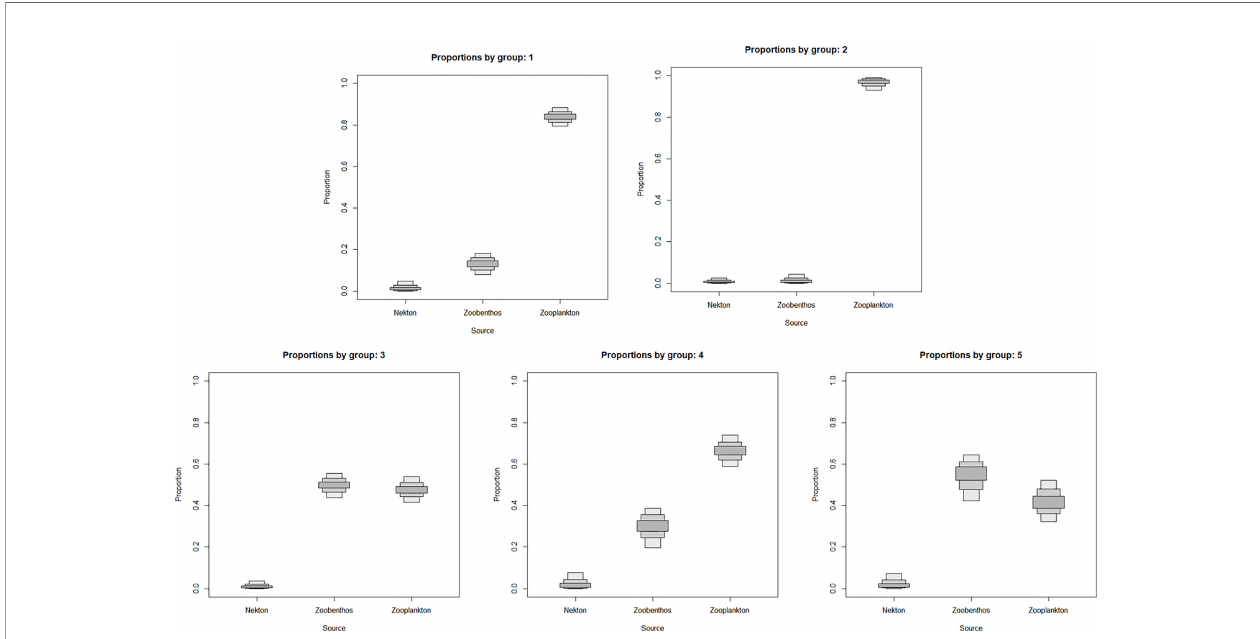
FIGURE 3 | Contributions of different food sources to fi ve sciaenid fi shes collected from the Zhoushan Archipelago between 2019 and 2021. Group 1 is Larimichthys polyactis ; Group 2 is Collichthys lucidus ; Group 3 is Johnius belangerii ; Group 4 is Nibea albi fl ora ; Group 5 is Miichthys miiuy